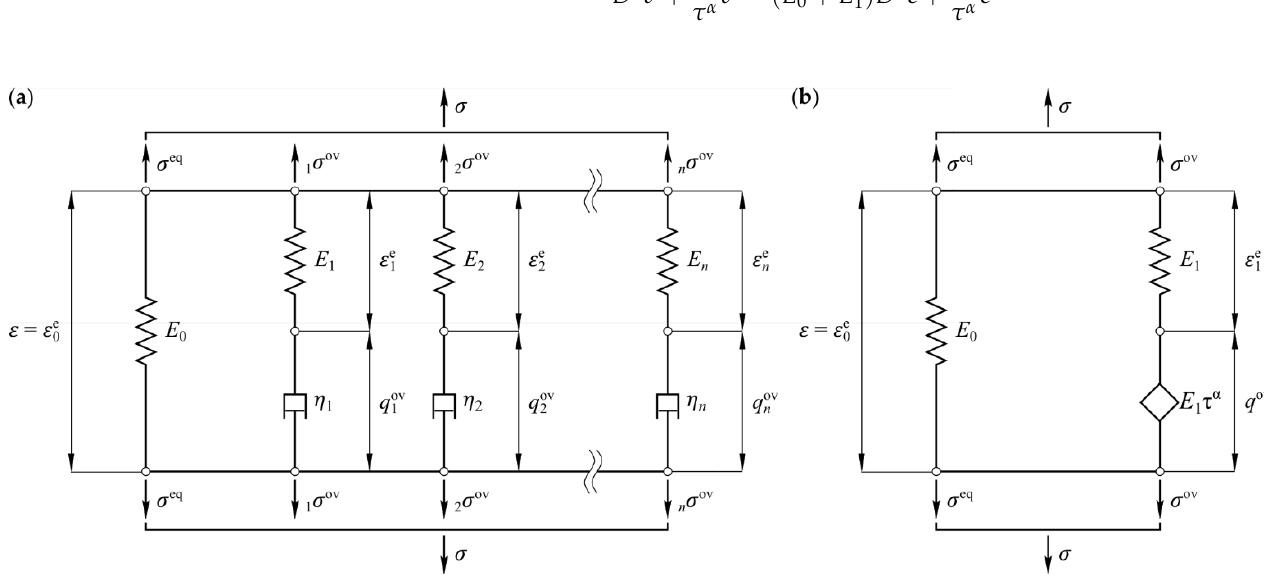
Figure 2. Schematic representation of used rheological models: ( a ) generalized Maxwell model, ( b ) fractional four-parameter model.